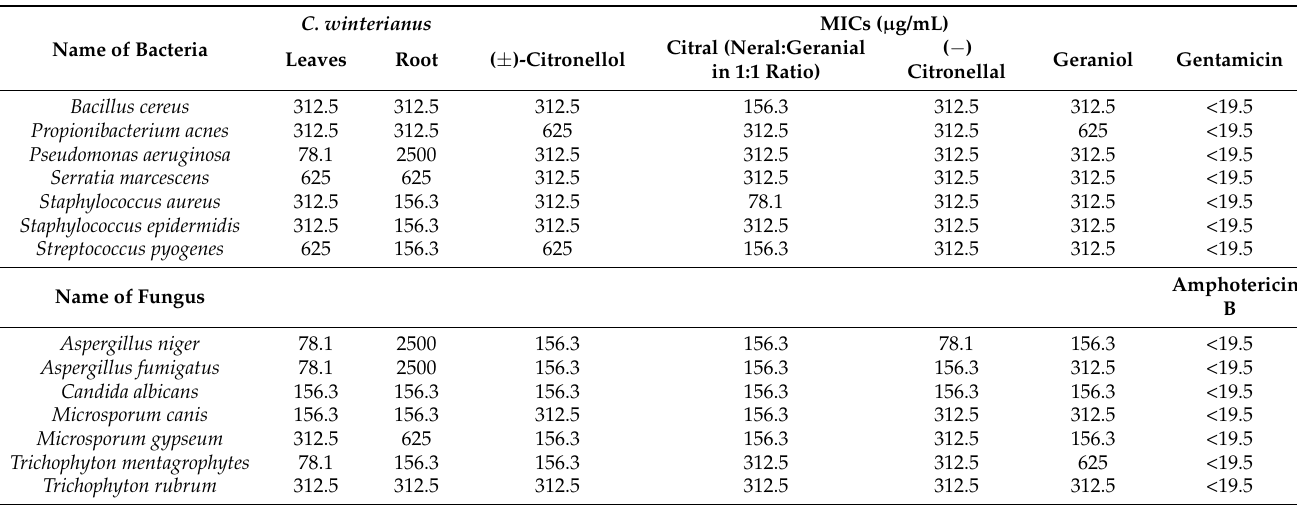
Table 6. Antimicrobial activity of C. winterianus essential oil and some major